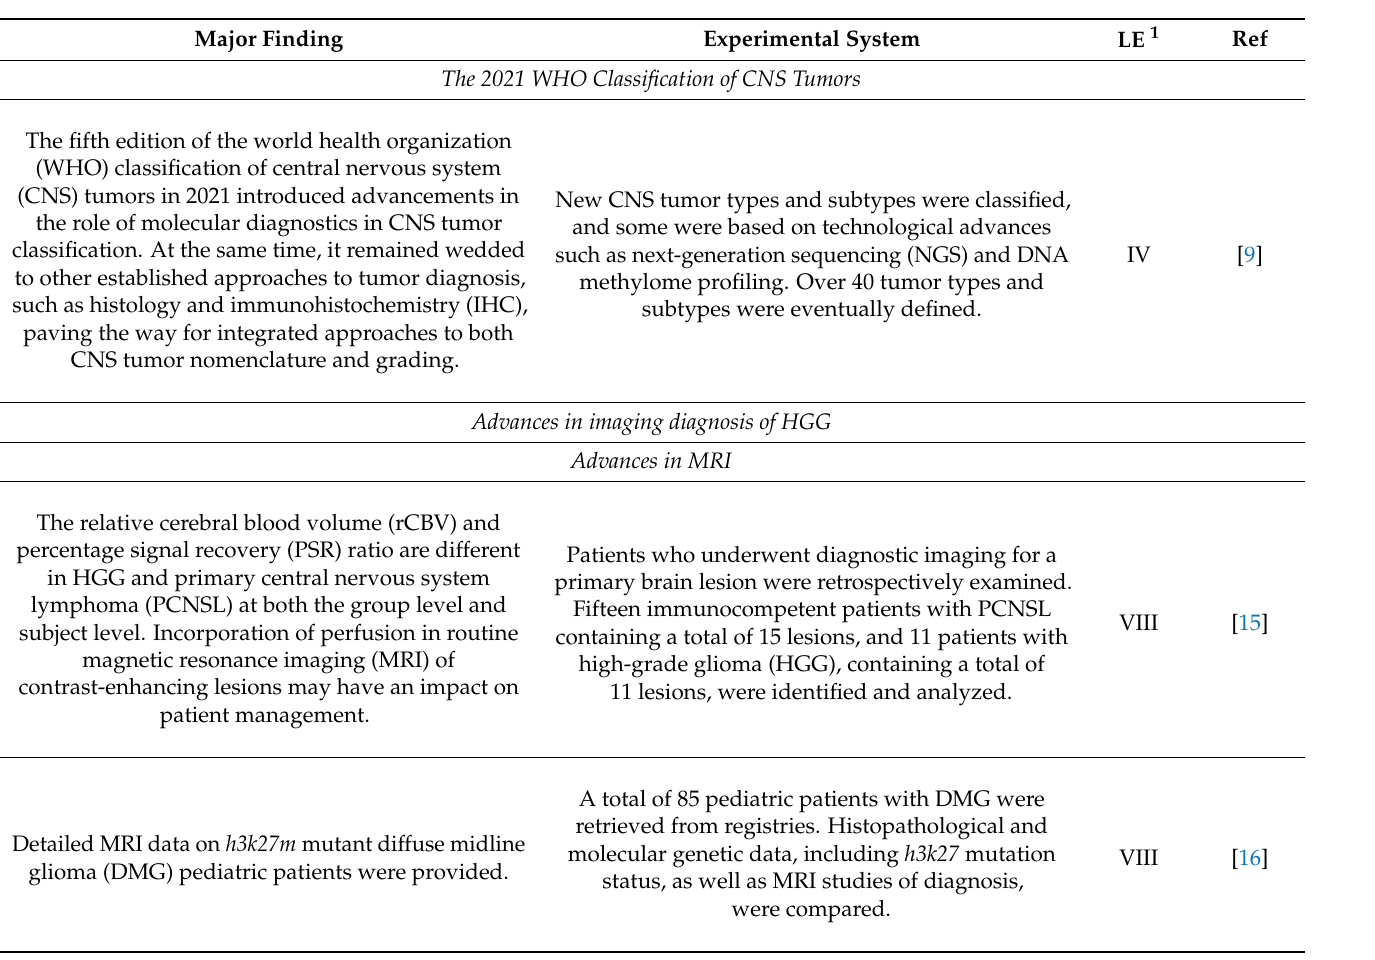
Table 1. Highlights of recent advances in the diagnosis of